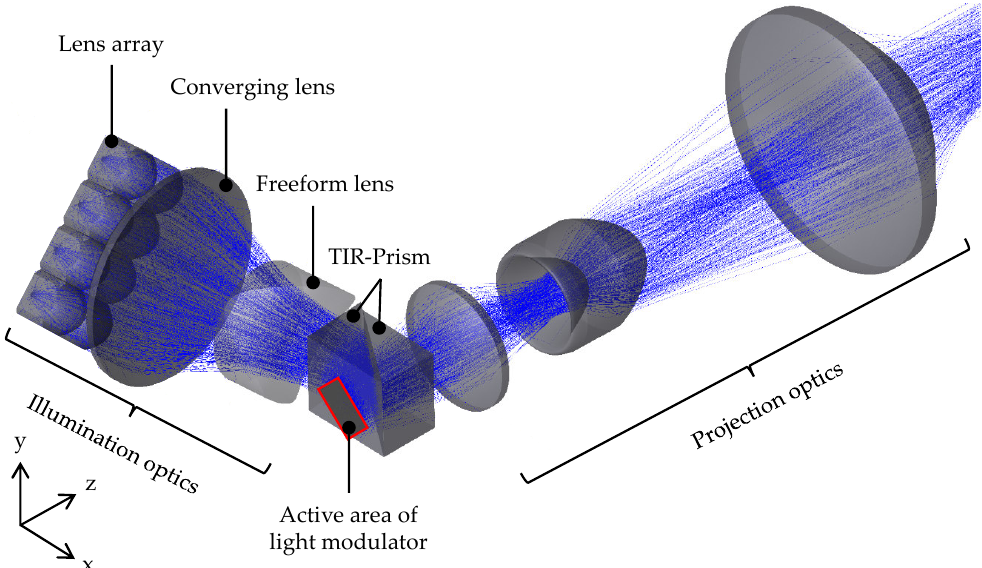
Figure 12. Non-sequential detailed design of a high-resolution lighting system according to